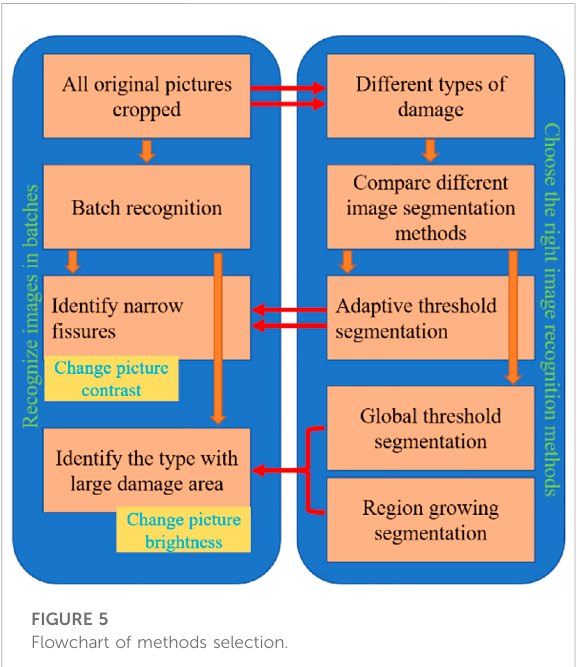
FIGURE 5 Flowchart of methods